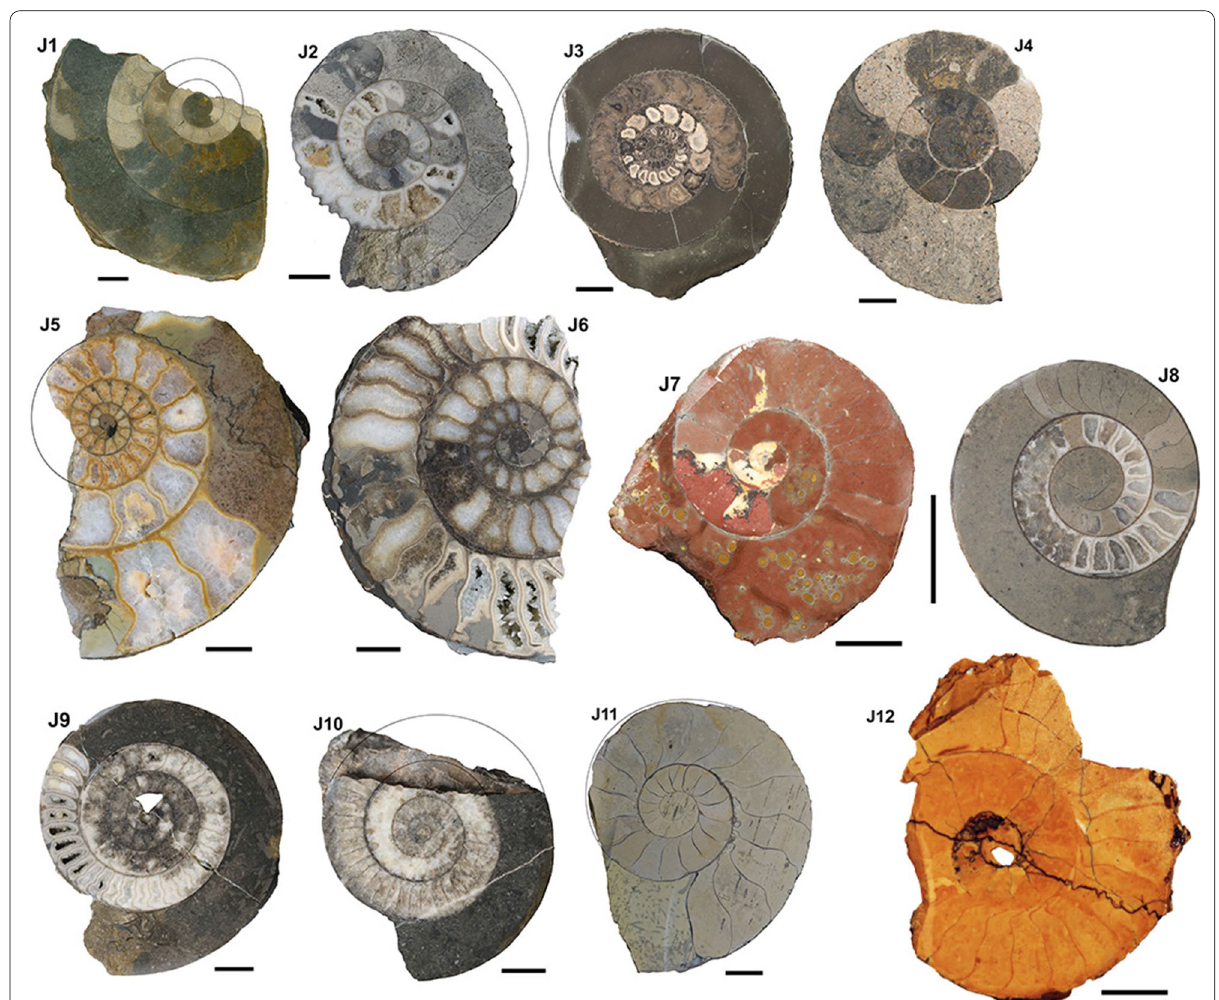
Fig. 2 Jurassic ammonoids, Hettangian to Aalenian (for details see Table 1). (J1, J2) Arietites sp. (J1) PIMUZ 6734, (J2) PIMUZ 37668, (J3) Dactylioceras commune (PIMUZ 13653; 0827), (J4) Asteroceras sp. (PIMUZ 13,007), (J5), Psiloceras naumanni (PIMUZ 12596), (J6) Schlotheimiia sp. (PIMUZ 12,618), (J7) Leioceras sp. (PIMUZ 37666), (J8–J10) Psiloceras planorbis (PIMUZ 12597; L/1207), (J9) PIMUZ 12597; L/1206), (J10) PIMUZ 12600, (J11), Lytoceras fimbriatum (PIMUZ 37665), (J12) Fuciniceras cf. isseli (PIMUZ 37733). Scale bar 1 =